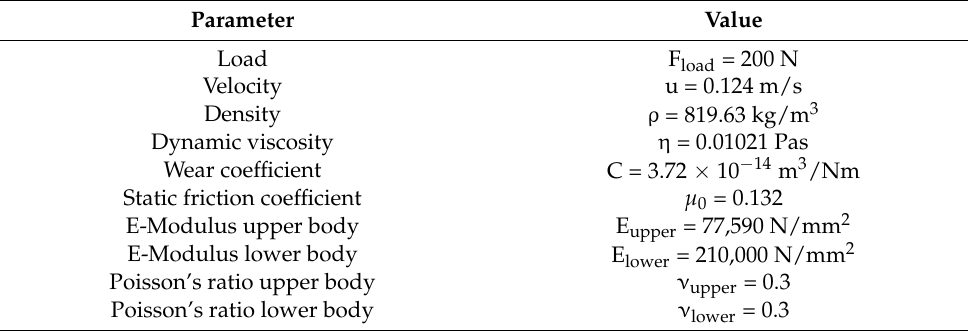
Table 2. Simulation parameters for the micro and macro